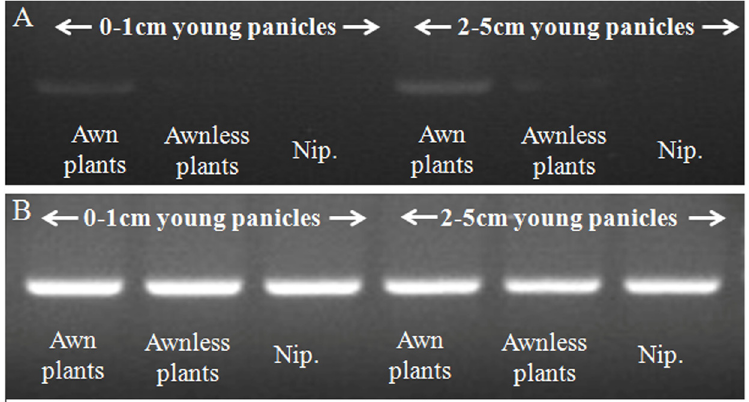
Fig 6. Semi-quantitative analysis of expression of Os04g0350700 . (A) Expression of Os04g0350700 in 0 – 1 cm and 2 – 5 cm young panicles of awned plants, awnless plants, with Nipponbare as control plants; (B) Expression of actin1 was used as a